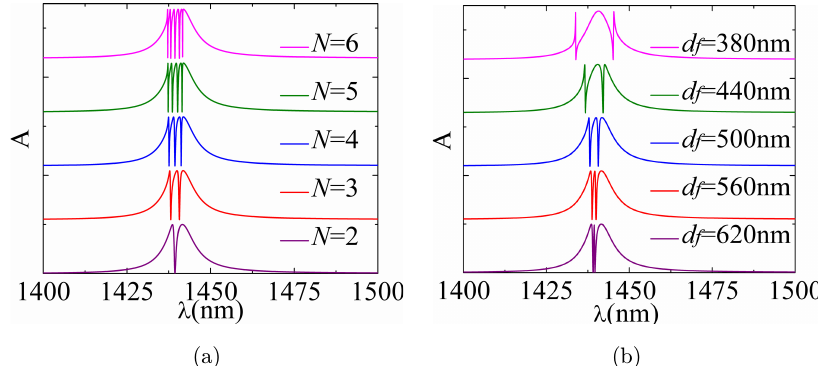
Fig. 4. The absorption as a function of wavelength (cid:6) , with relating to (a) the period N of 1DPC and (b) the thickness of defect layer F of structure EGBCBFBC,